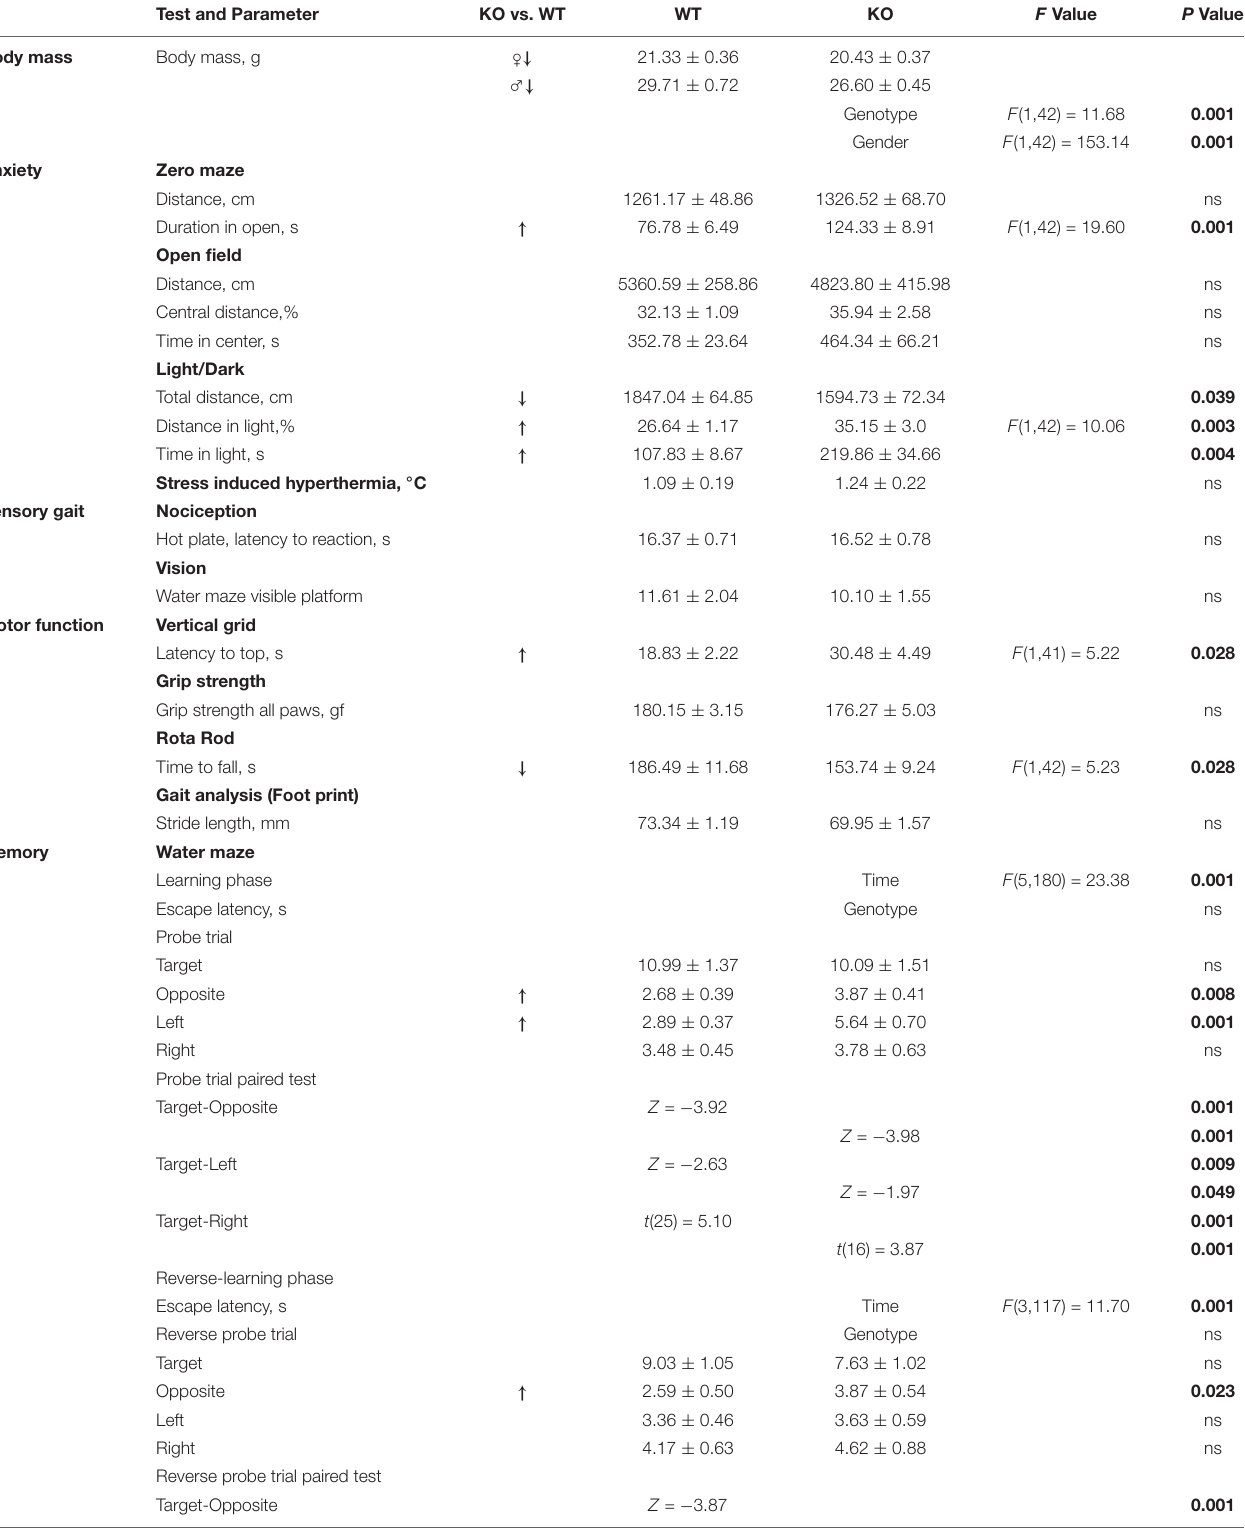
TABLE 1 | Behavioral Characterization of young MIM KO